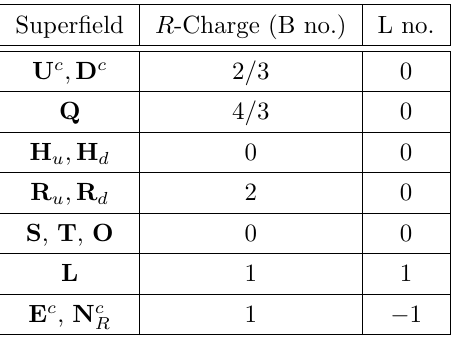
Table 1. Summary of super(cid:12)elds with their R -charge (baryon number) and lepton number as- signments. Each antichiral super(cid:12)eld has R -charge opposite to that of the corresponding chiral